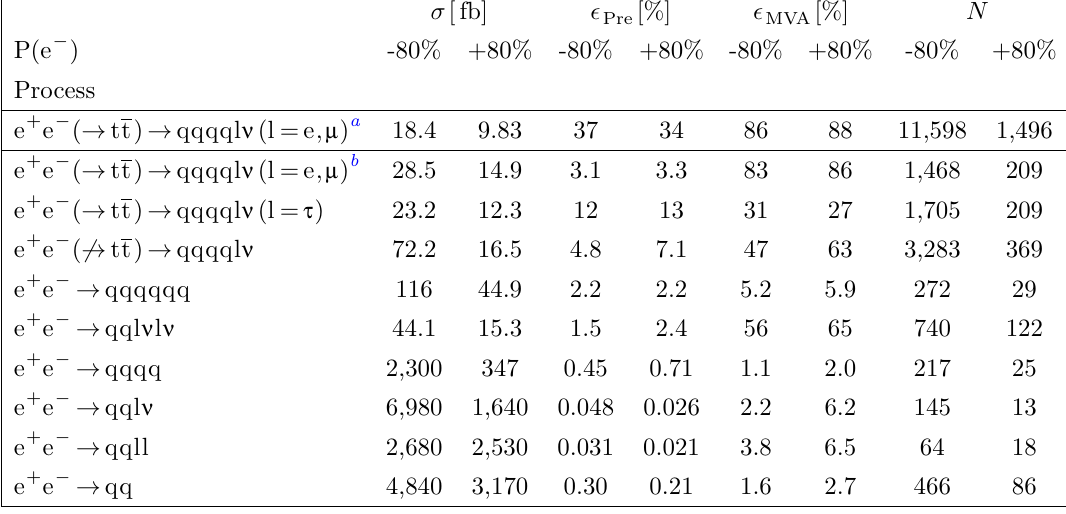
Table 19. Pre-selection and (cid:12)nal event selection e(cid:14)ciencies and expected number of events for the analysis of tt production with radiative events in the interval 900 GeV (cid:20) assuming an integrated luminosity of 2 : 0 ab (cid:0) 1 and 0 : 5 ab (cid:0) 1 for P (e (cid:0) ) = -80% and P (e (cid:0) ) = +80%, respectively.